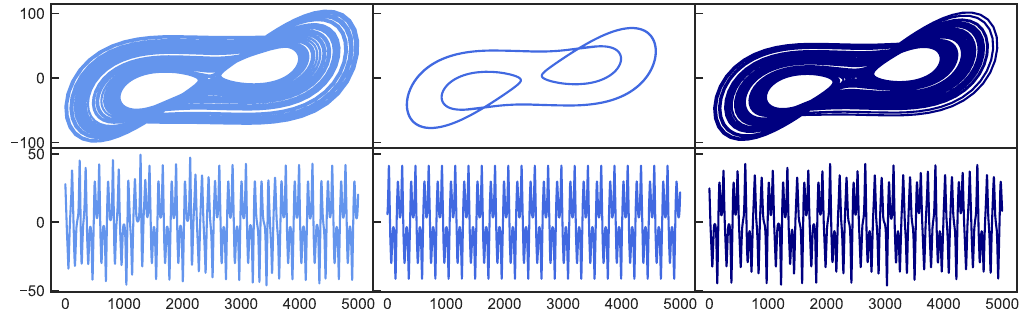
Figure 1. Periodic to chaotic control. Top: 2D attractor representation in the x–y plane. Bottom: X coordinate time series. Left plots show the original chaotic state which changes to a periodic state (middle) after tuning the order parameter. After applying the control mechanism, the system is forced into a chaotic state again